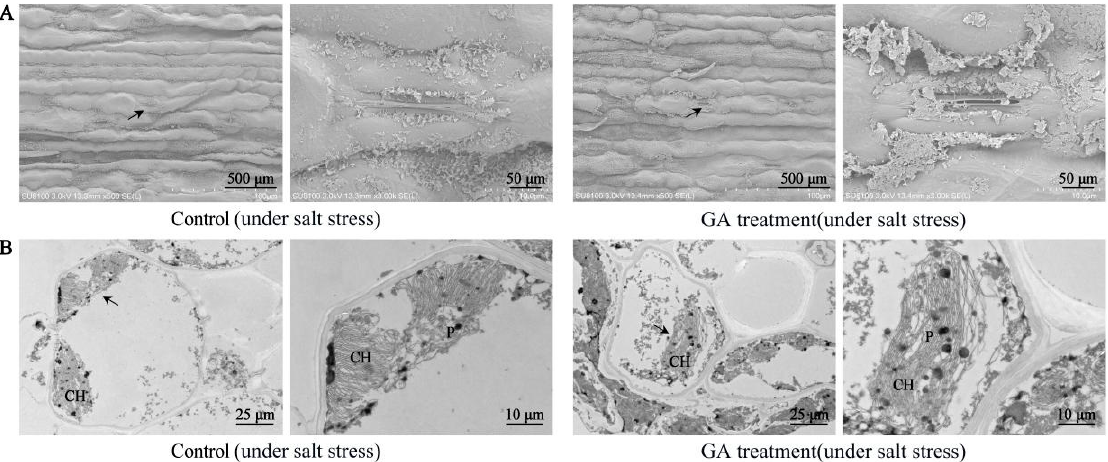
Figure 5. The outcome of GA 3 treatment on the anatomical structure of sorghum leaves under salt stress. ( A )—Influence of GA 3 (50 mg/L) treatment on the epidermal structure and stomatal status of sorghum leaves under salt stress; ( B )—influence of GA 3 (50 mg/L) treatment on the cellular ultrastructure of sorghum leaves under salt stress; the figure on the right is an enlarged version of the area marked by a black arrow on the left figure. CH—chloroplast; P—plastoglobuli. 2.5. m 6 A-M Profile within Sorghum under GA 3 Treatment, as Evidenced by a